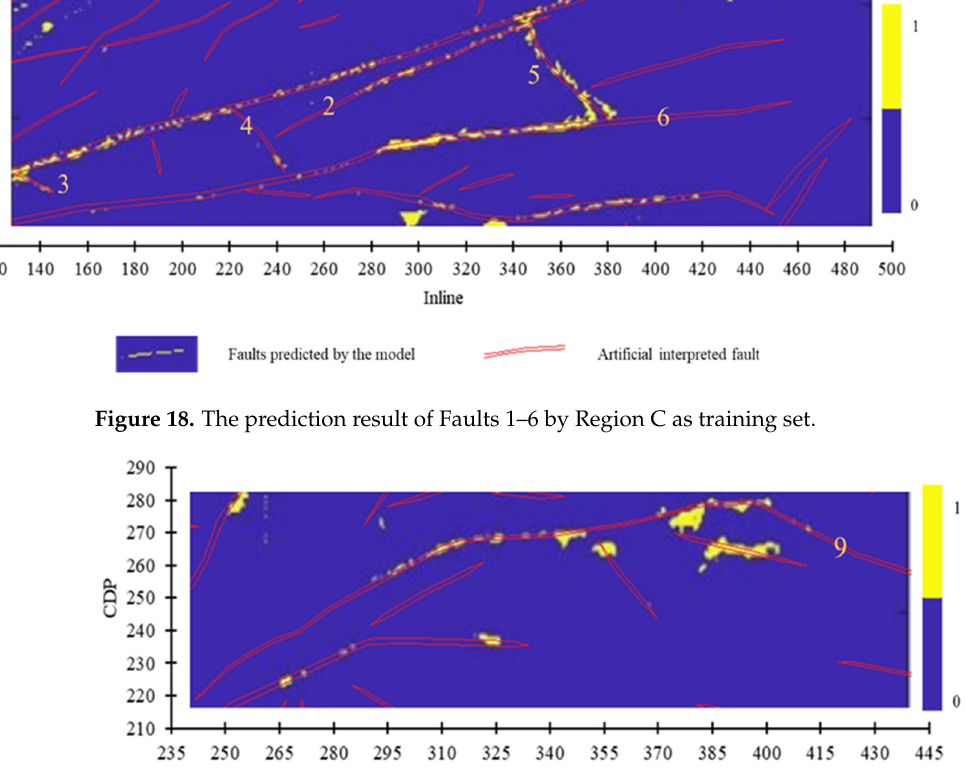
Figure 20. The prediction result of Fault 10 by Region C as training set . The fault prediction result by Region D is displayed in Figures 21 and 22. Fault 1 to Fault 8 can be predicted, but the continuity of predicting results is not as good as Region A and Region C.